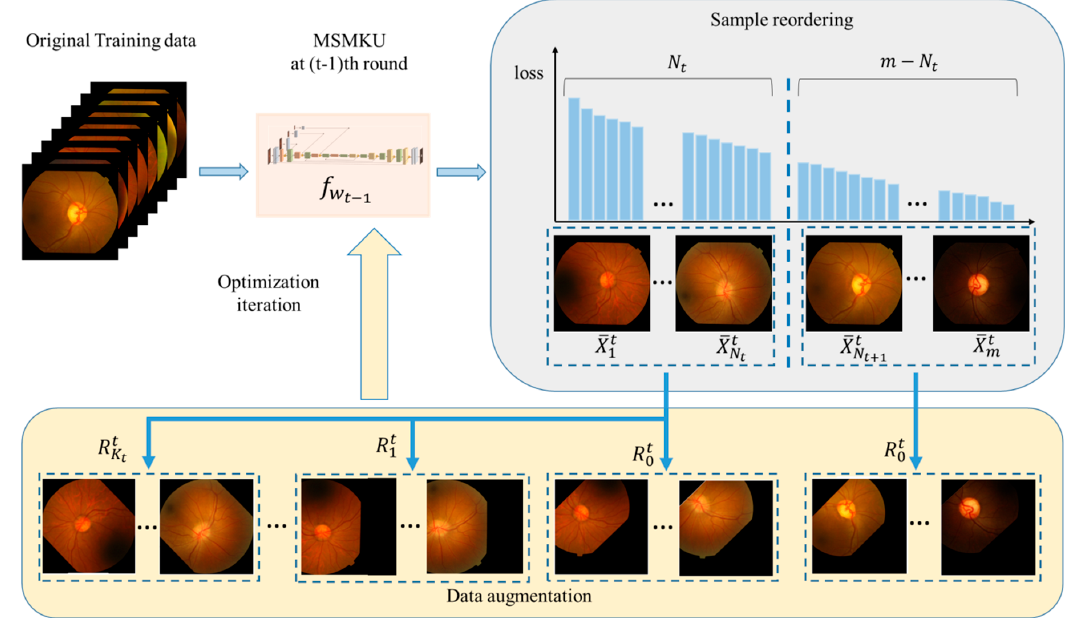
Figure 5. Data augmentation and parameter iteration based on loss sorting. Algorithm 1 Mixed Maximum Loss Minimization Training for MSMKU